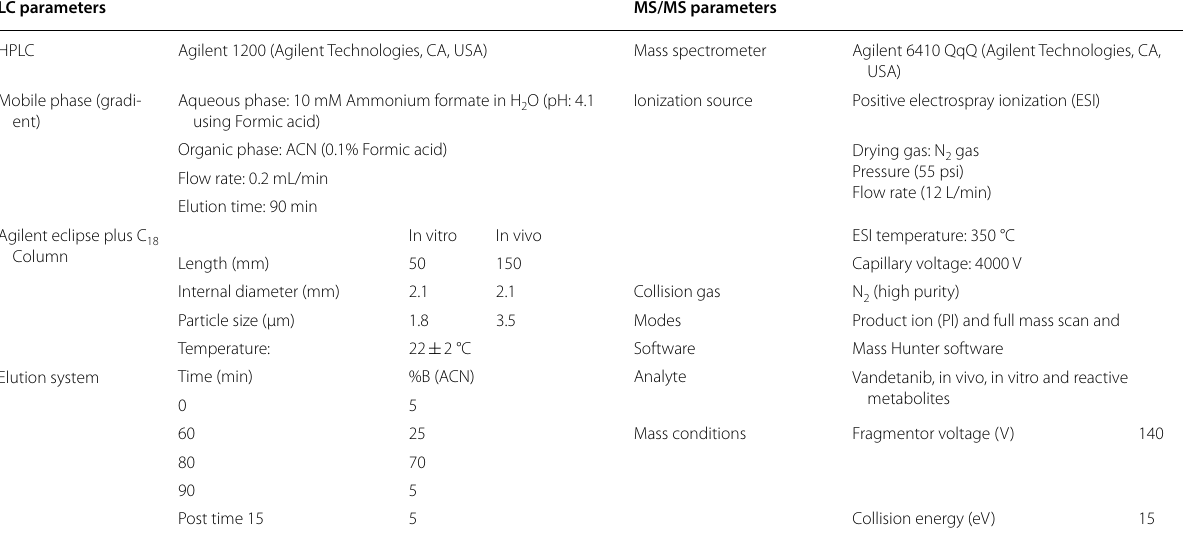
Table 2 Optimized parameters of the established LC–MS/MS methodology LC